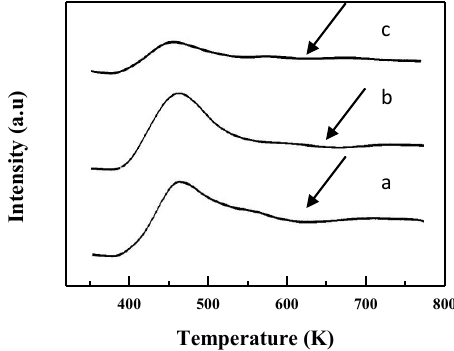
Figure 6. NH 3 -TPD profiles of ( a ) 1.4 wt% TiO 2 -6.1 wt% Cr 2 O 3 /SiO 2 -400; ( b ) 1.4 wt% TiO 2 -6.1 wt% Cr 2 O 3 /SiO 2 -500; and ( c ) 1.4 wt% TiO 2 -6.1 wt% Cr 2 O 3 /SiO 2 -600. The distributions of Ti, Cr, and Ni of 2.9 wt% TiO 2 /SiO 2 -500, 1.4 wt% TiO 2 -6.1 wt% Cr 2 O 3 /SiO 2 -500, and 7.1 wt% Cr 2 O 3 -6.3 wt% NiO/SiO 2 -500 inside the SiO 2 pellet were analyzed with electron